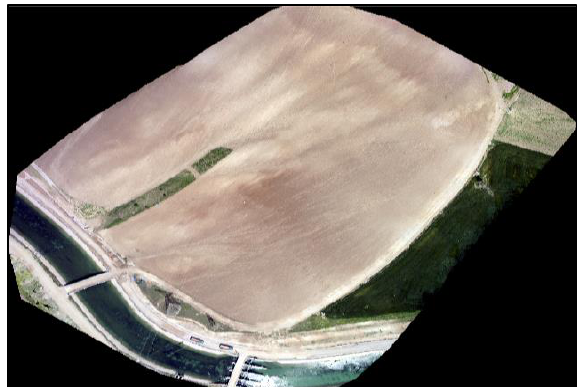
Figure 2.Orthophoto of the study area acquired dated 04/24/2017